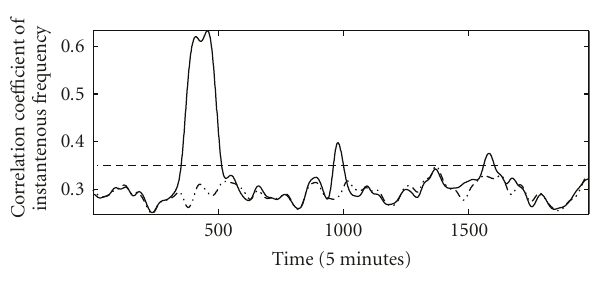
tra ffi c are not been cleared; the dash-dot line is the correlation coe ffi cient of anomalous space without inserted attacks. Two observations are available from the dash-dot line (comparing with the dotted line ): (1) it changes more moderate than coef- ficient resulting directly from the instantaneous